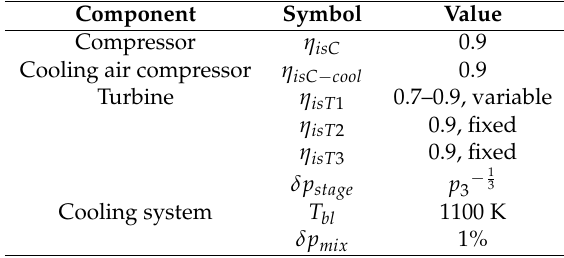
Table 2. Model parameters and